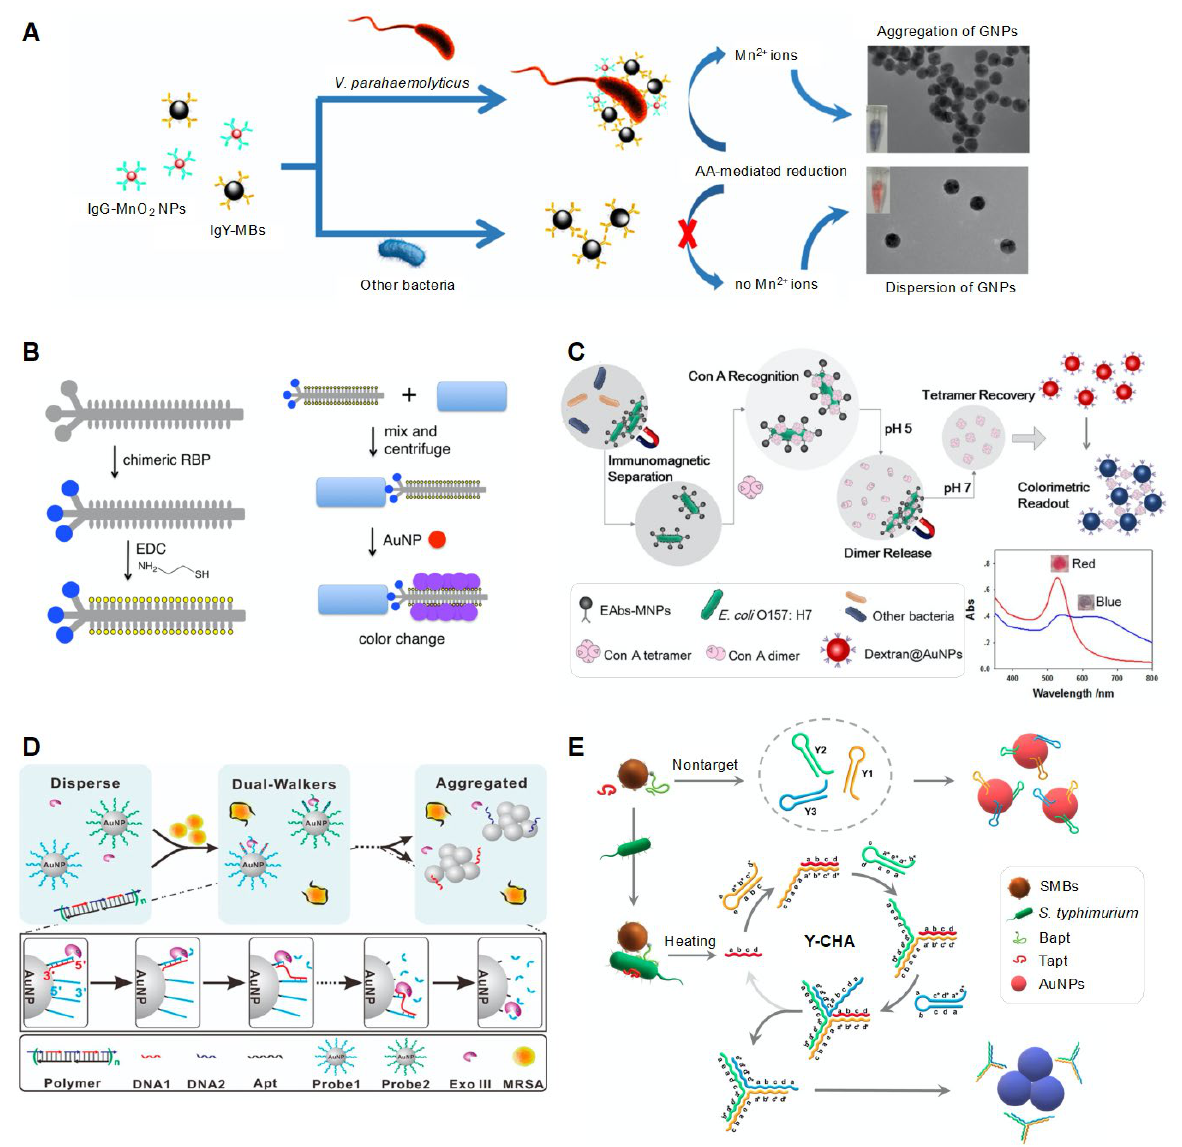
Figure 4. Colorimetric sensing strategy based on the aggregation of NPs. ( A ) Detection of Vibrio parahemolyticus based on Mn 2+ -mediated aggregation of AuNPs. Reprinted with permission from [51]. Copyright 2018, American Chemical Society. ( B ) Detection of Escherichia coli , Vibrio cholerae , Pseudomonas aeruginosa, and Xanthomonas campestris based on engineered bacteriophage-mediated aggregation of AuNPs. Reprinted with permission from [52]. Copyright 2018, American Chemical Society. ( C ) Detection of E. coli O157:H7 through pH-responsive concanavalin A-mediated aggregation of AuNPs. Reprinted with permission from [54]. Copyright 2017, Springer Nature. ( D ) Detection of Staphylococcus aureus using DNA dual-walker signal amplification combined with colorimetric systems. Reprinted with permission from [56]. Copyright 2020, American Chemical Society. ( E ) Detection of Salmonella typhimurium using colorimetric systems in combination with the aptamer-catalytic hairpin assembly (CHA) method. Reprinted with permission from [57]. Copyright 2021, MDPI. GNP, gold nanoparticle; AA, ascorbic acid; RBP, receptor-binding protein; EDC, 1-ethyl-3-(3-dimethylaminopropyl)-carbodiimide; ConA, concanavalin A; MNP, magnetic nanoparticle; ExoIII, exonuclease III; MRSA, methicillin-resistant S. aureus ; SMB, streptavidin-coated MNP; Bapt, biotinylated aptamer; Tapt, non-labelled aptamer; Y-CHA, Y-shaped catalytic hairpin assembly. A diverse pathogen-detecting system was developed using bacteriophages (Figure 4B) [52]. The bacteriophage acted as a ligand for binding to specific species and an NP